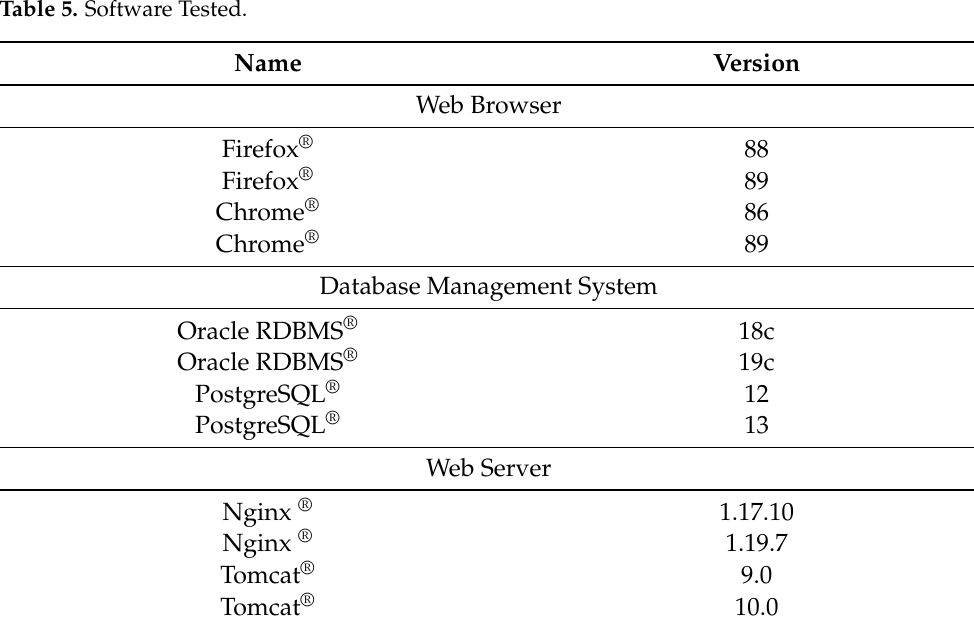
Table 5. Software